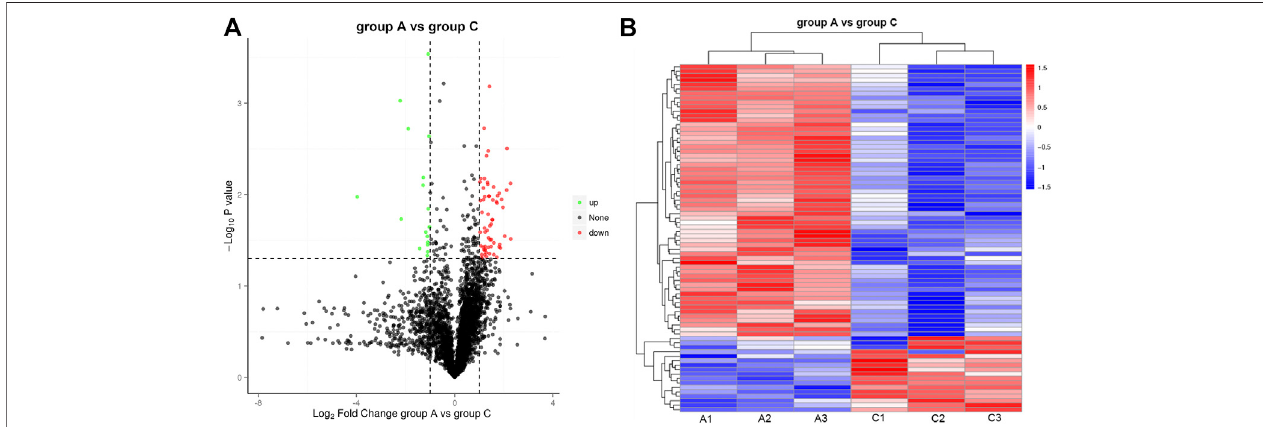
FIGURE 4 | Illustration of DEP quanti fi ed from the label-free analysis (A) Volcano plots of protein abundance between group A and group C. Green dots represent downregulated protein (FC ≤ 0.05, p -value ≤ 0.05), and red dots represent upregulated protein (FC ≥ 2.0, p -value ≤ 0.05). (B) Heat map of hierarchical clustering of DEP. Red indicates high expression protein, and blue indicates low expression protein.